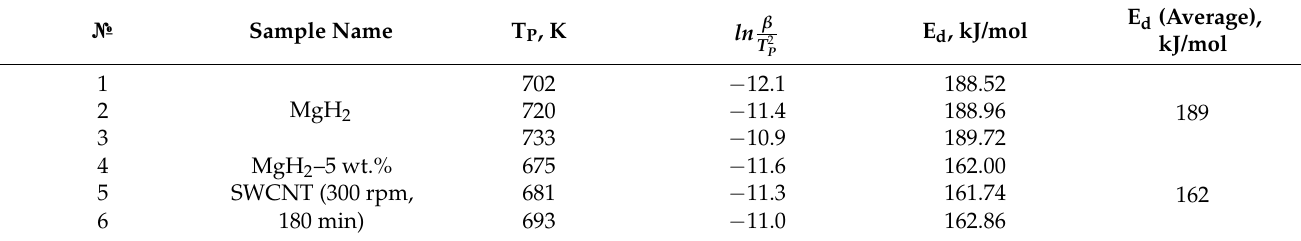
Table 1. Calculation of the activation energy of hydrogen desorption.